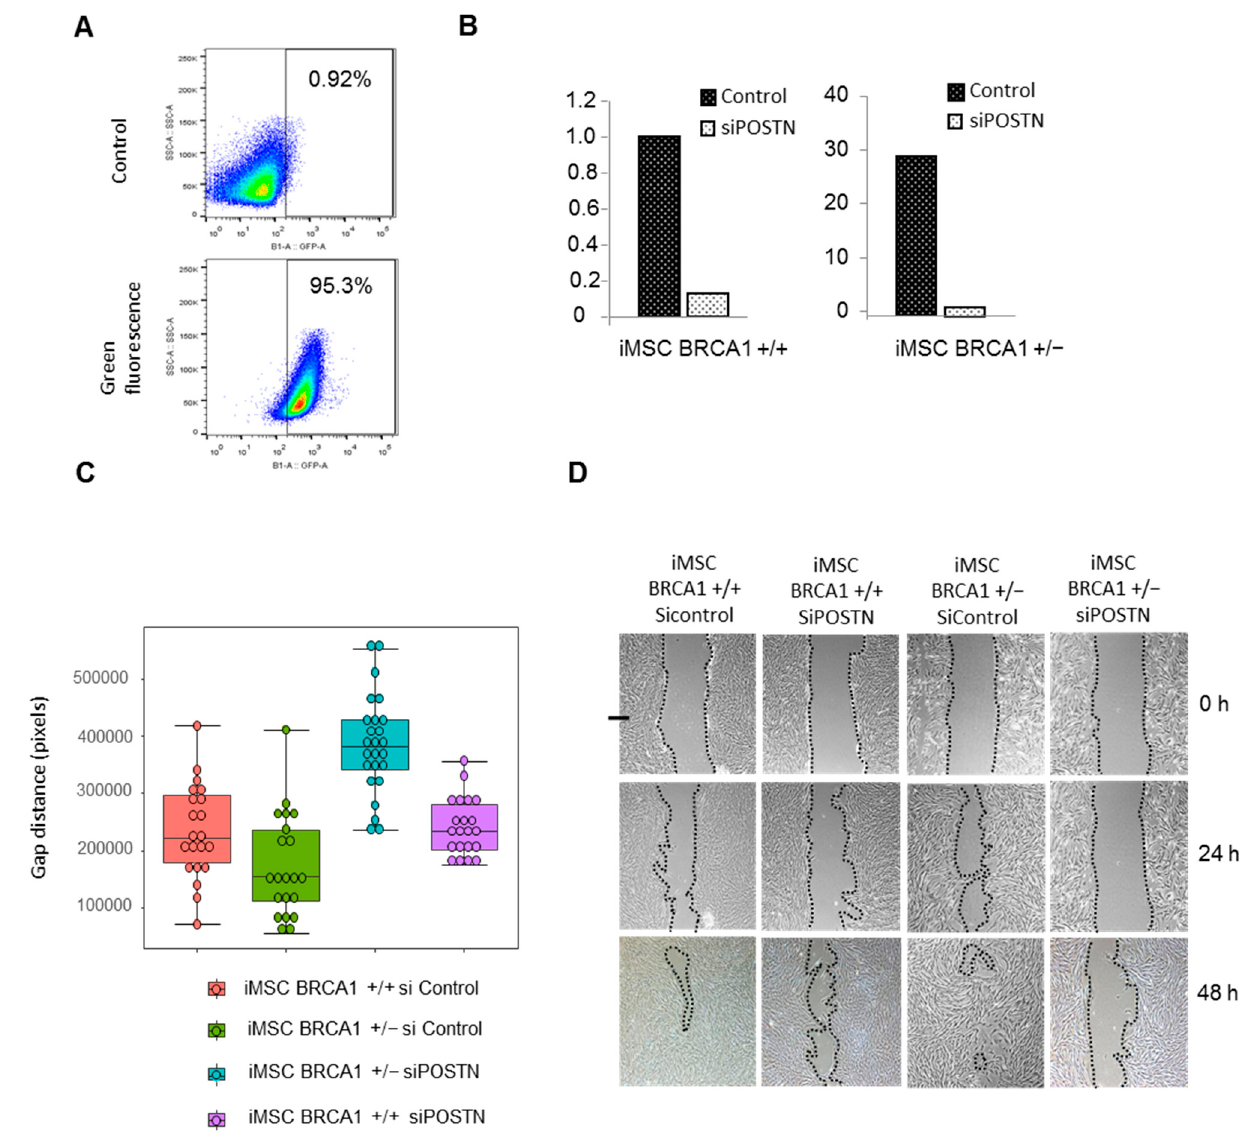
Figure 6. Wound-healing assay with BRCA1 +/ − and BRCA1 +/+ iMSCs after transfection with siRNA against POSTN. ( A ) Evaluation of the transfection efficacy in BRCA1 +/ − iMSCs using fluorophore-labeled siRNA. ( B ) Knockdown of POSTN mRNA in both cell lines as evaluated by quantitative RT-PCR. ( C ) Cell migration ability was measured at 48 h with a wound-healing assay using cell lines transfected with POSTN siRNA and siRNA control. ( D ) Representative photomicrographs of the gaps for transfected BRCA1 +/ − and BRCA1 +/+ iMSCs in culture at different time points (24 and 48 h) after scratching in a wound-healing assay.